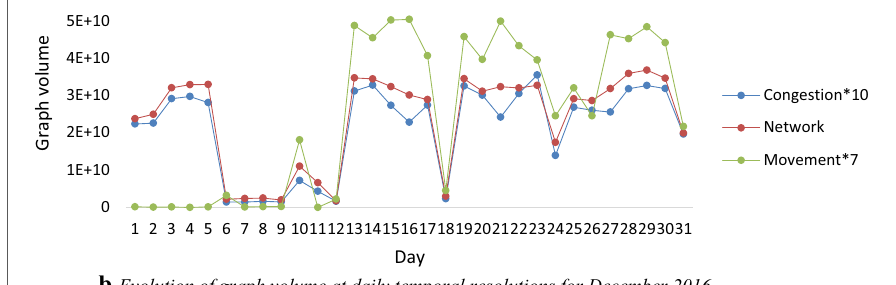
Fig. 9 Evolution of graph density and volume at daily temporal resolutions for December 2016